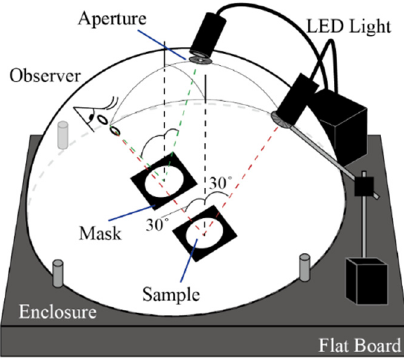
Figure 3. Experimental set up for sensory tests using a point light source.